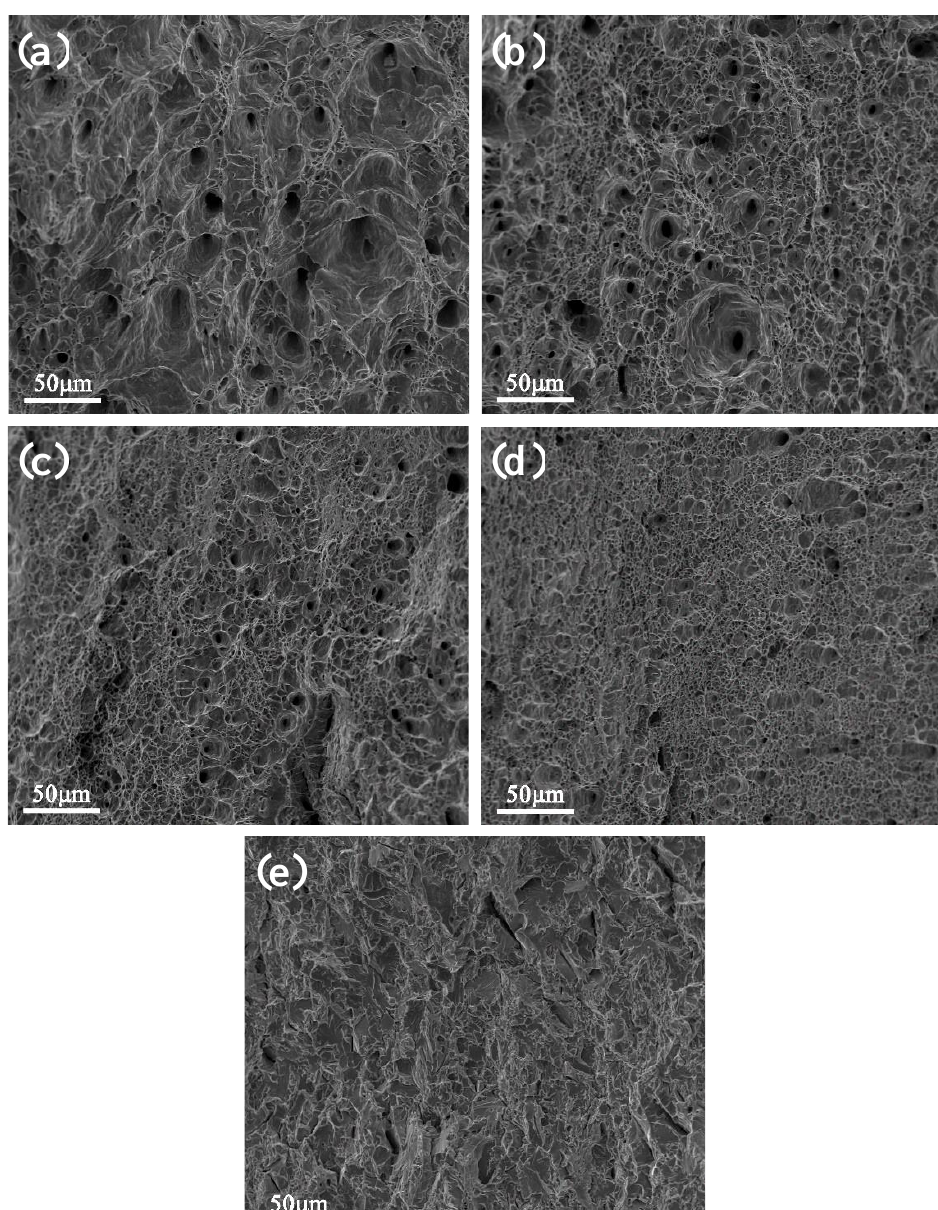
Figure 8. SEM micrographs showing the impact fracture surfaces at −80 °C after: ( a ) water cooling; and aging for ( b ) 0.5 h; ( c ) 1 h; ( d ) 1.5 h; and ( e ) 3 h.